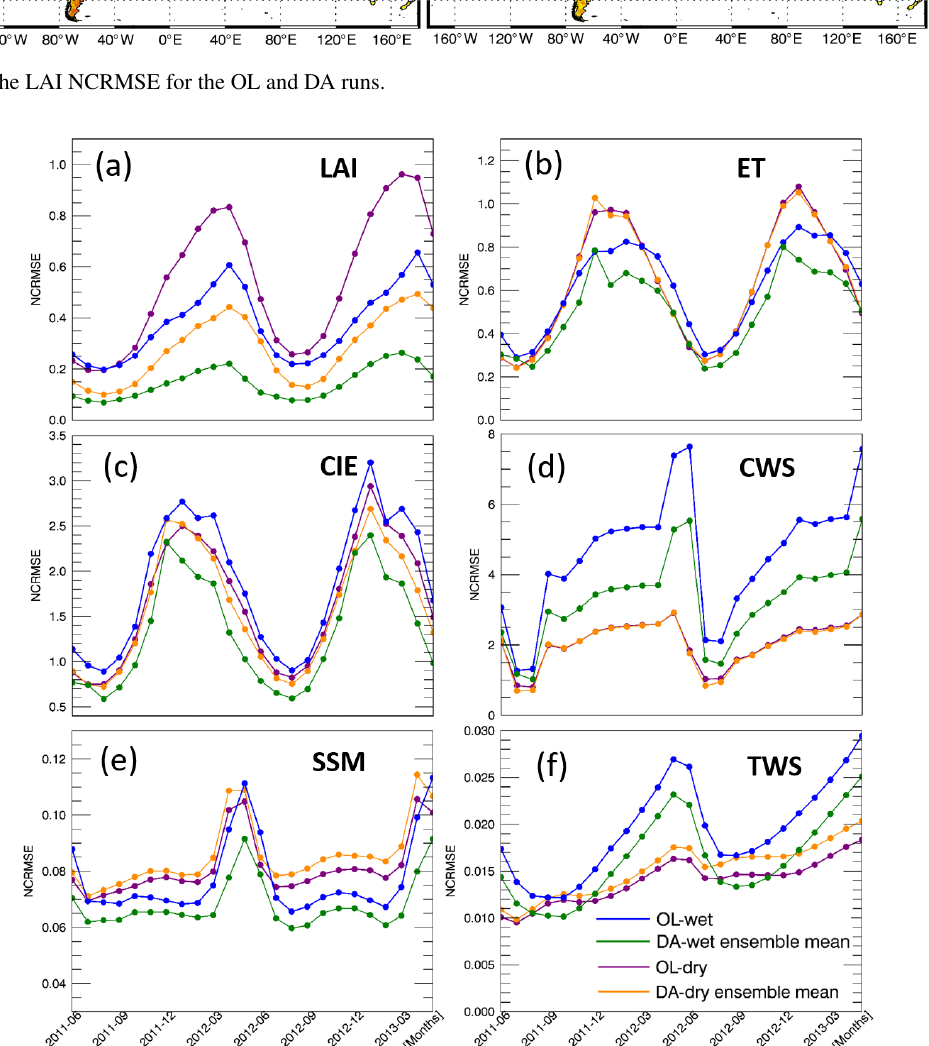
Figure 6. Monthly averaged NCRMSE for LAI and five water variables over the Northern